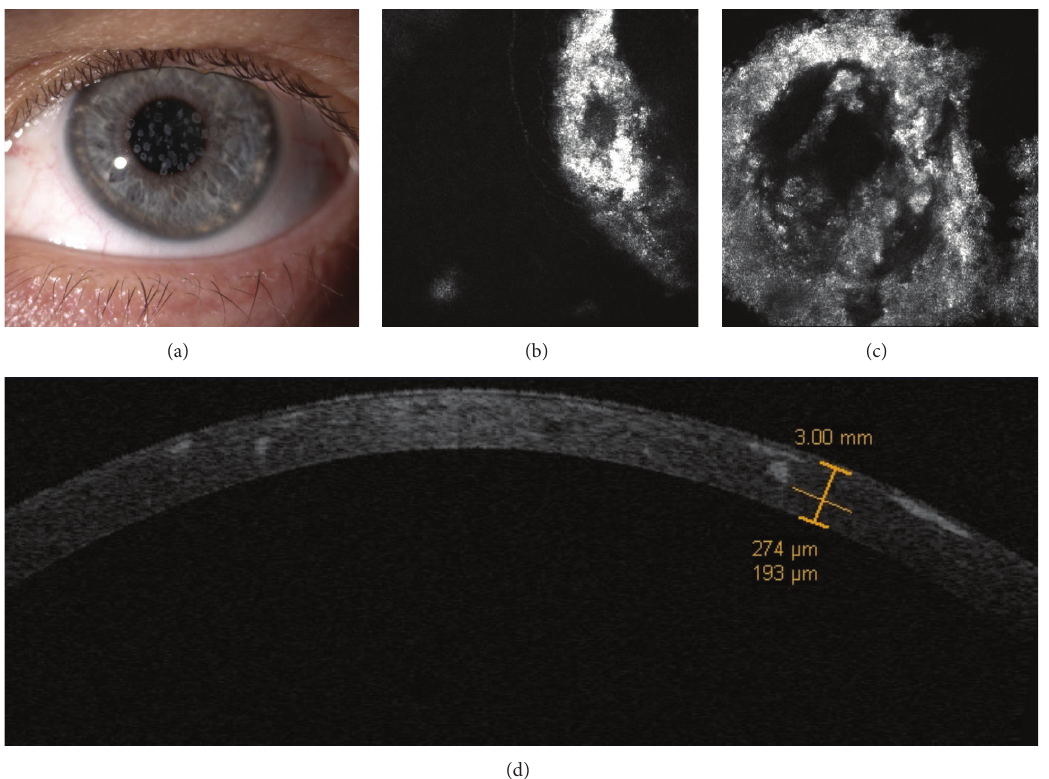
Figure 1: Case 1 , the mother. Corneal biomicroscopy at 25x magnification shows multiple round, sharply demarcated whitish granular deposits in the central cornea. Stellate opacities, though in numerical inferiority, are also detectable (a). IVCM reveals focal multiple hyperreflective circular deposits with dense aspect (maybe of amyloid origin) surrounding internal multiple irregular hyperreflective spots (maybe of hyaline origin), often surrounding the subepithelial nerve fibers (b and c). Time domain corneal OCT scan provides an overall view of the cornea with topographic detection and depth estimation of hyperreflective deposits